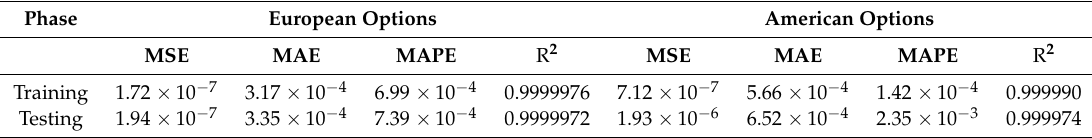
Table 3. Performance of IV-ANN.